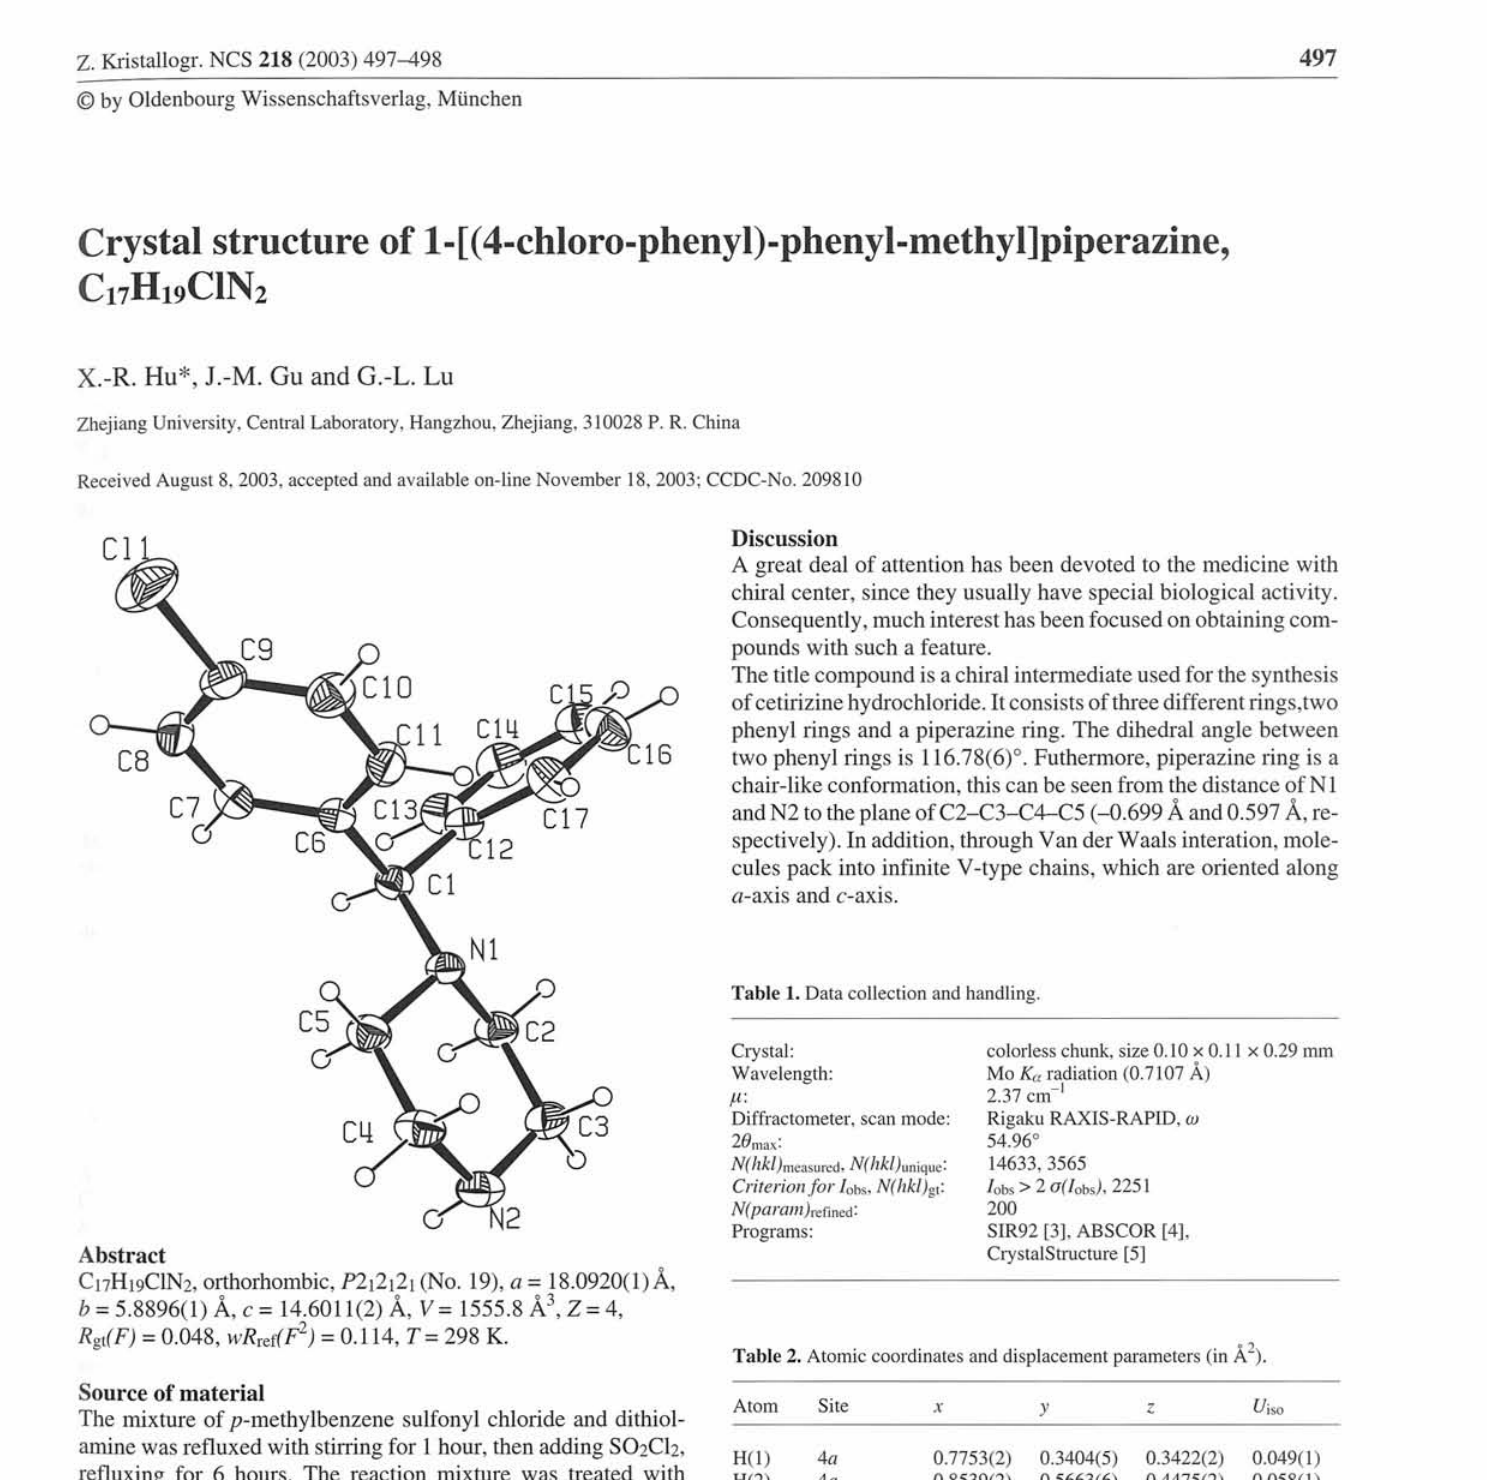
Table 2. Atomic coordinates and displacement parameters (in